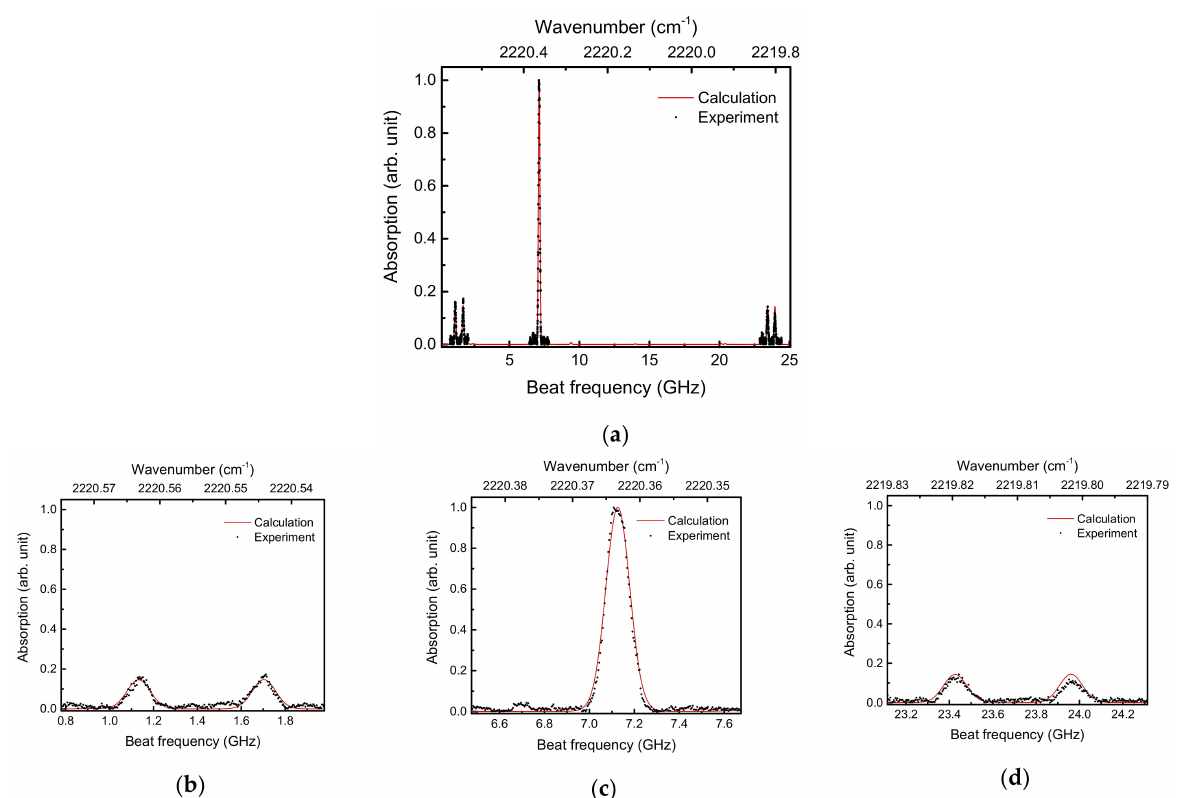
Figure 7. N 2 O absorption lines observed with broadband heterodyne spectroscopy. The experimental data are dots, and the red lines are calculated absorptions of N 2 O based on SpectraPlot. The experimental and calculated spectra were normalized by maximum values in the determining areas. ( a ) Entire frequency range. ( b – d ) Enlarged absorption spectra corresponding to the beat frequency domains of 0.78–1.98 GHz, 6.47–7.67 GHz, and 23.1–24.3 GHz,